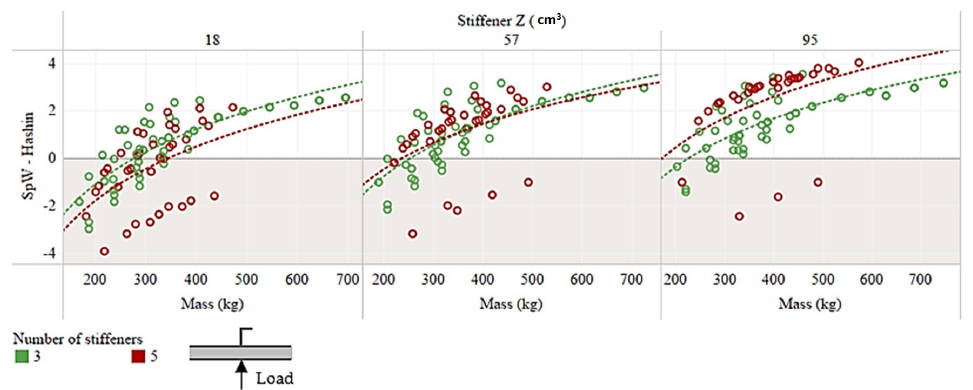
Figure 16. The influence of number of stiffeners on the stiffener section modulus against Hashin criteria. Red represents a 3 stiffener configuration and green represents a 5 stiffener configuration.